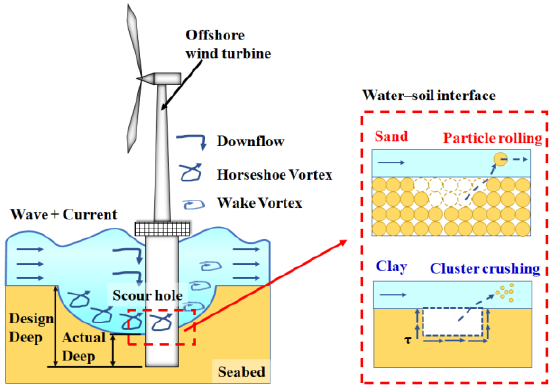
Figure 2. Schematic diagram of the scour mechanism for an OWT.